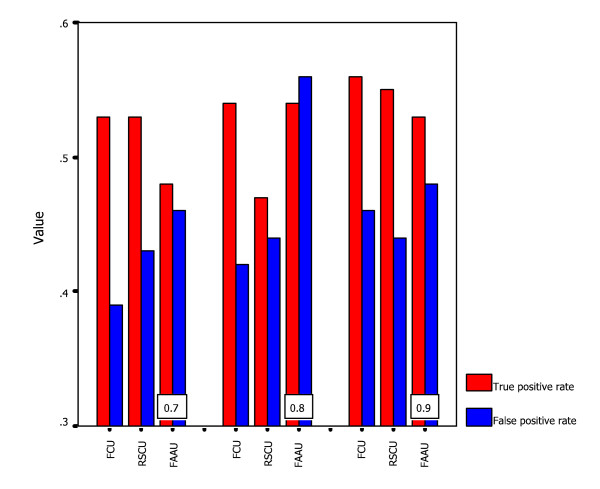
The performance of SVM for predicting cold ORFs from the full genome. The numerical value stuck on each bar cluster denotes the recombination rate cutoff of cold ORFs.